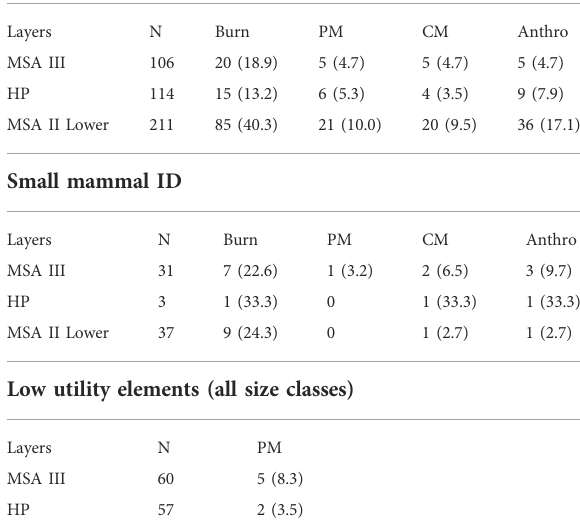
TABLE 8 Anthropogenic marks on small mammal remains and low utility elements. Burn = burnt bone, PM = percussion marks, CM = cut marks, Anthro = anthropogenic marks (cut and/or percussion marks per specimen). ‘ Small mammals ’ are all specimens identi fi ed to size 1 and smaller. ‘ Small mammal ID ’ are identi fi ed small mammals such as hyrax, Cape dune mole rat and porcupine. Low utility elements = phalanges, innominate and